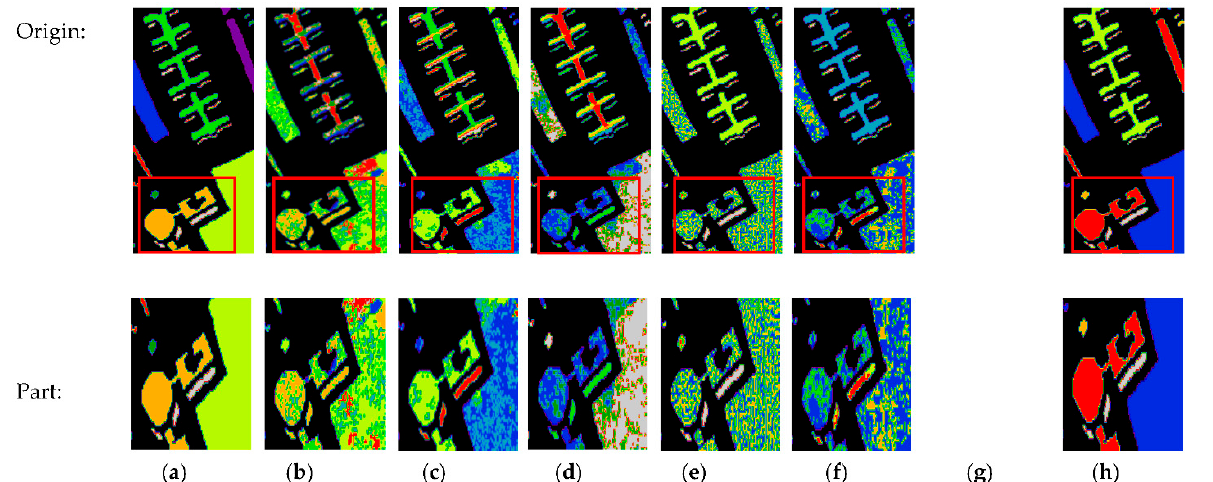
Figure 7. Clustering results obtained using different methods on the Indian Pines corrected data set with salt and pepper noise. ( a ) Ground truth. ( b ) LRSC 40.29%. ( c ) SSC 44.75%. ( d ) S4C 50.63%. ( e ) EDSC 52.88%. ( f ) EGCSC 57.07%. ( g ) EKGCSC 56.09%. ( h ) SSAKGCSC 66.34%.